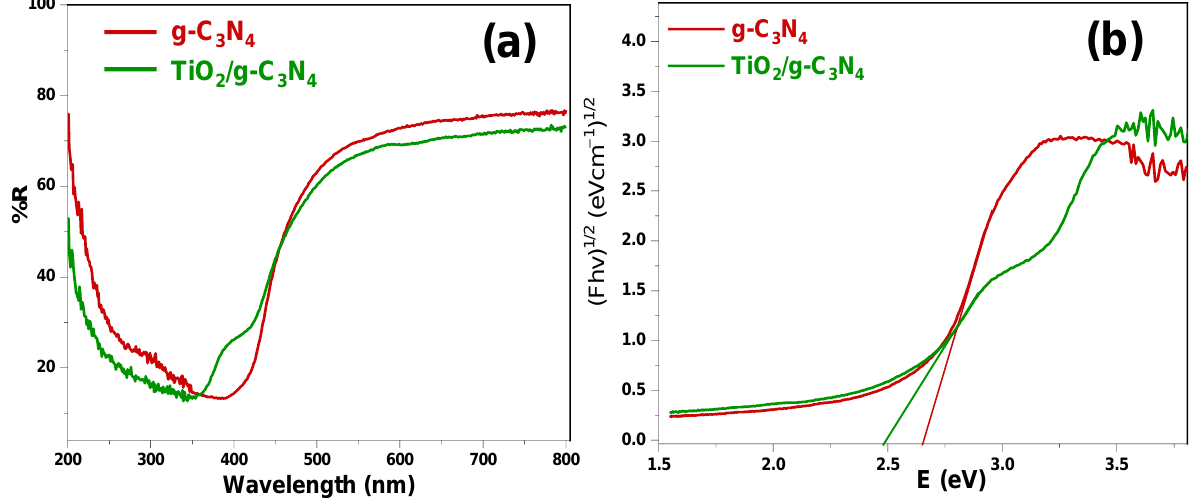
Figure 4. Diffuse Reflectance Spectra ( a ) and plot of transferred Kubelka-Munk versus energy of the light absorbed ( b ) of pure g-C 3 N 4 and TiO 2 /g-C 3 N 4 .